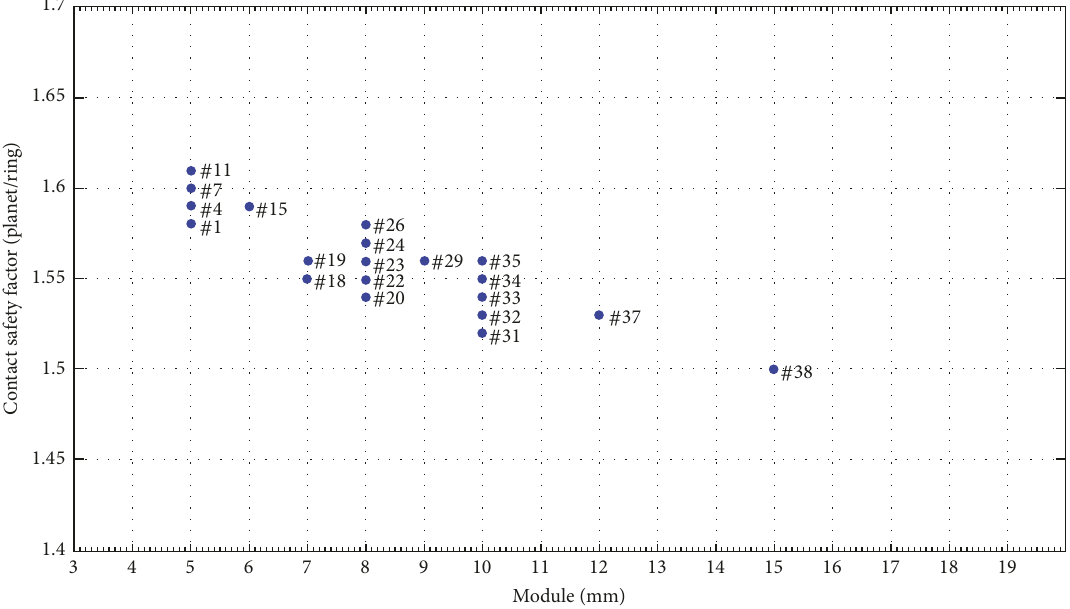
Figure 17: Safety factor on contact between ring and planet gears.